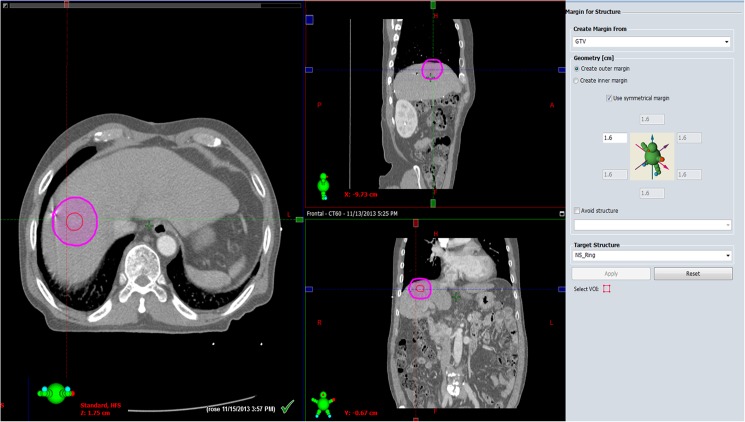
Calculating the distance semi-automatically between the tumor margin and a marker in 3-dimensional space creating a curved line parallel to the outer margin of the tumor using planning CT workstation.Firstly, draw a line along tumor margin. Second, create a curved line parallel to the outer margin of the tumor at marker site using workstation tool. And the distance between the tumor margin and a marker is automatically calculated as 1.6cm.